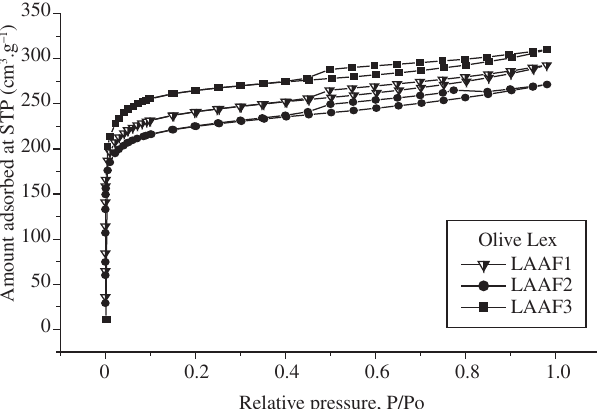
Figure 6. Pore Size Distribution by DFT method for the physically activated . 2